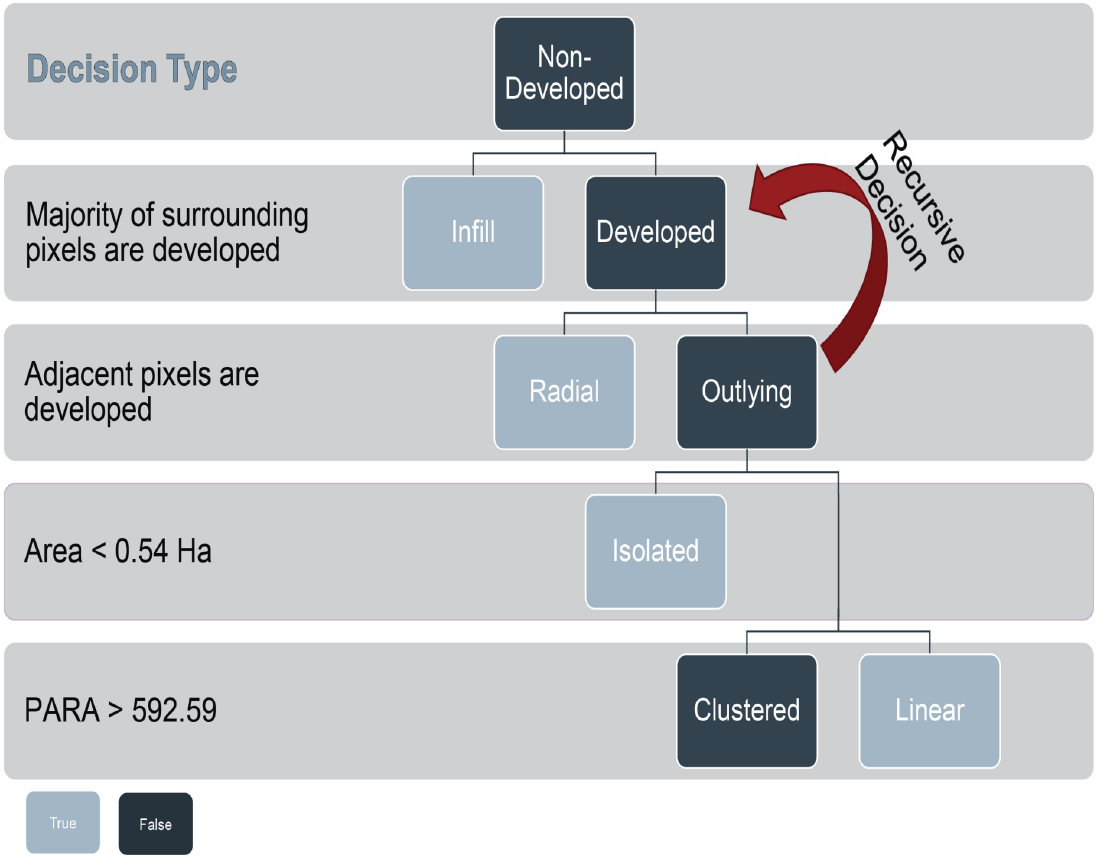
Fig 2. Categorization flowchart for developed lands. This includes the rules used to identify patch, perforated and interior wildlands.